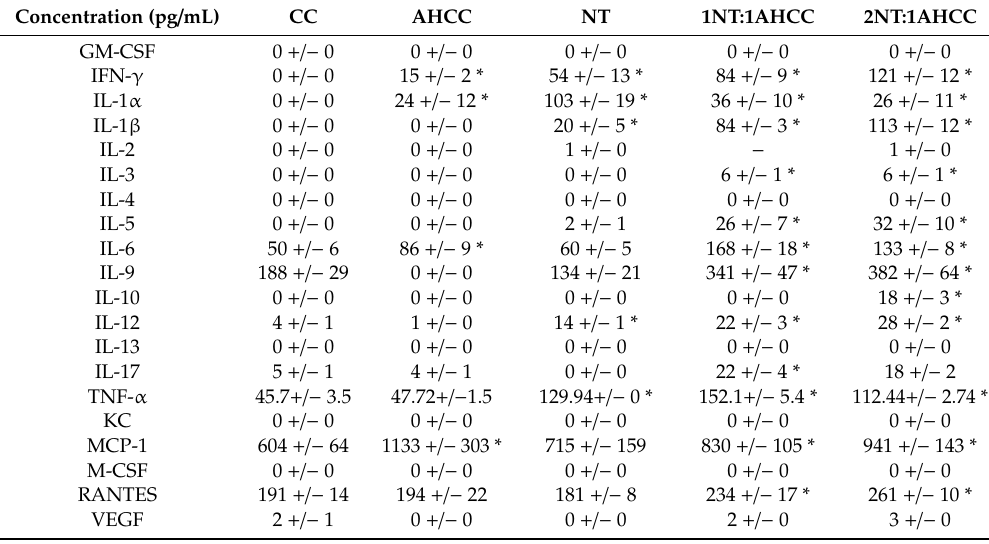
Table 2. Cytokine quantification after exposure to nucleotides (NTs), AHCC, and their combinations in cocultures of lymphocytes and naïve macrophages. Each value represents the mean +/ − standard deviation for three replicates. * p < 0.05 versus the control.